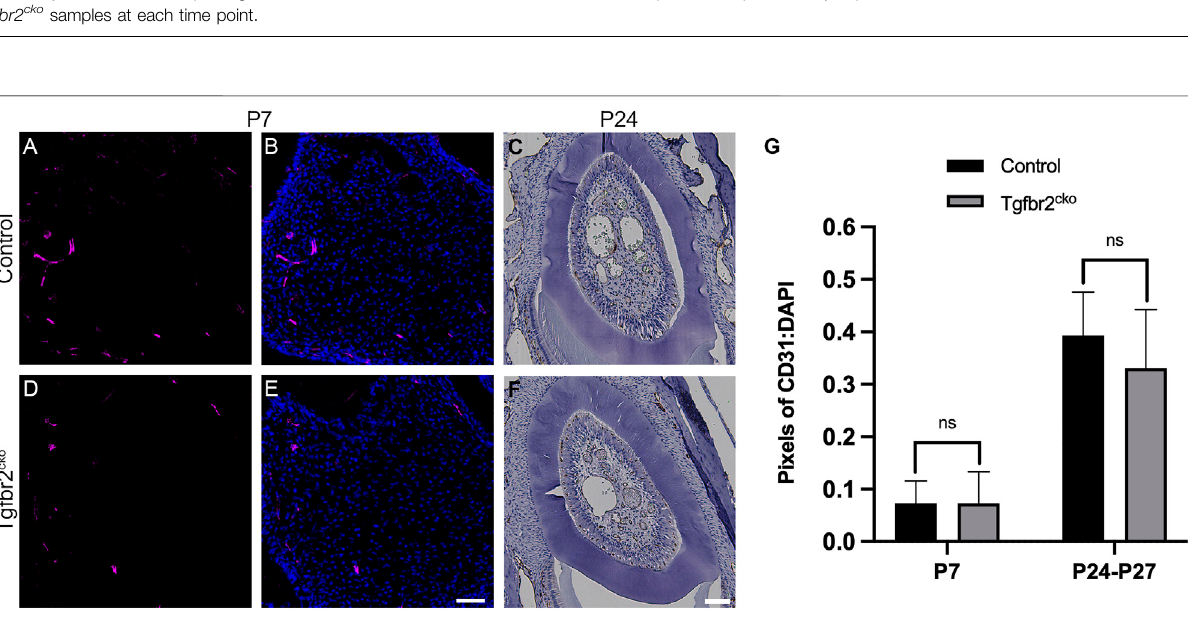
Frontiers in Cell and Developmental Biology |